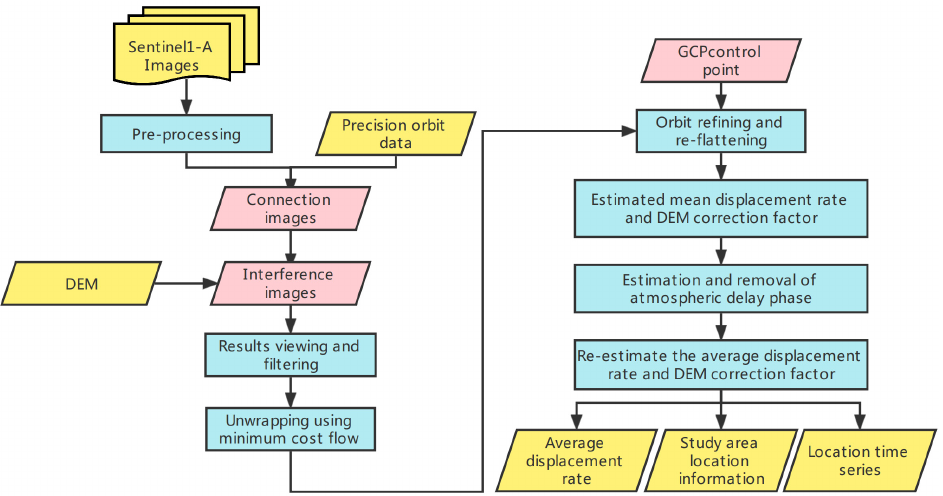
Figure 3. Illustrates the processing flow of